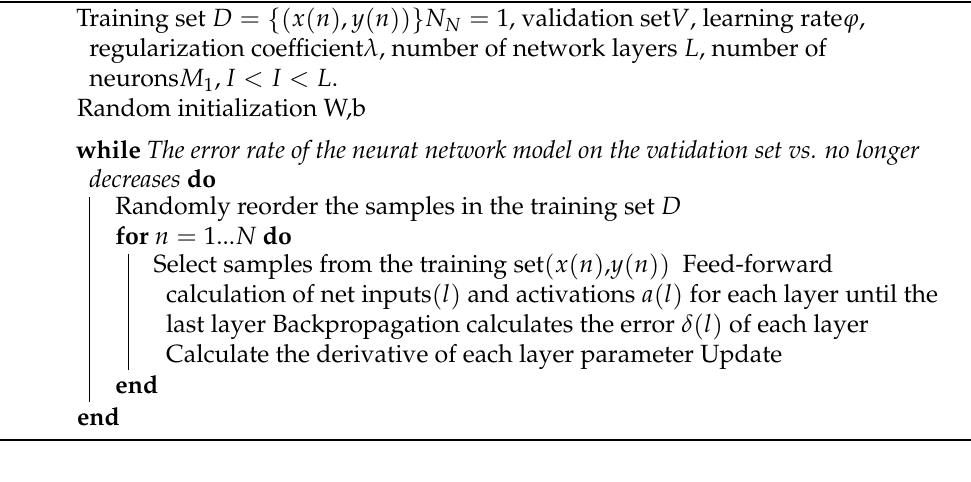
Algorithm 1: Algorithmic representation of the training process in this paper.